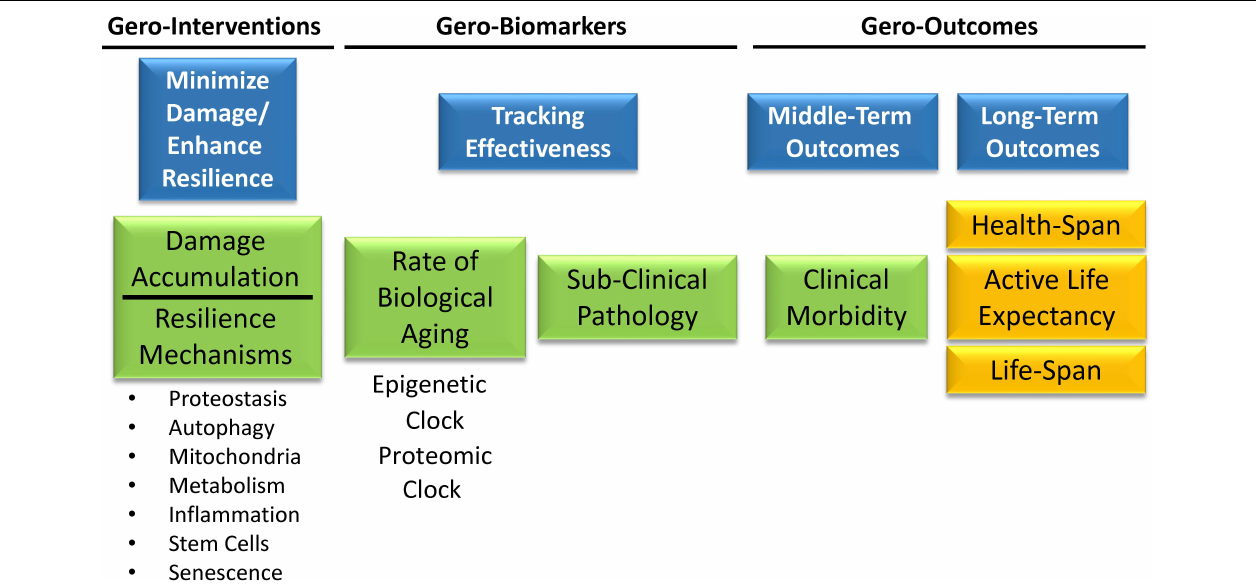
FIGURE 8 | Gero-interventions aim to target one or more putative mechanisms of aging among those already discovered, or others still undiscovered. A primary aim will be demonstrating a beneficial effect on the rate of biological aging estimated by biomarkers signatures, such as the “epigenetic” or the “proteomic” clock, and on some subclinical pathology such as “arterial stiffness” or “amyloid accumulation.” Another aim will be to demonstrate that changes in biological aging and subclinical pathology prevent middle-term outcomes important for aging, such as multimorbidity or lower extremity performance. Finally, these trials will need to demonstrate that the intervention substantially changes the trajectory of aging by preventing physical and cognitive disability and promoting longevity.